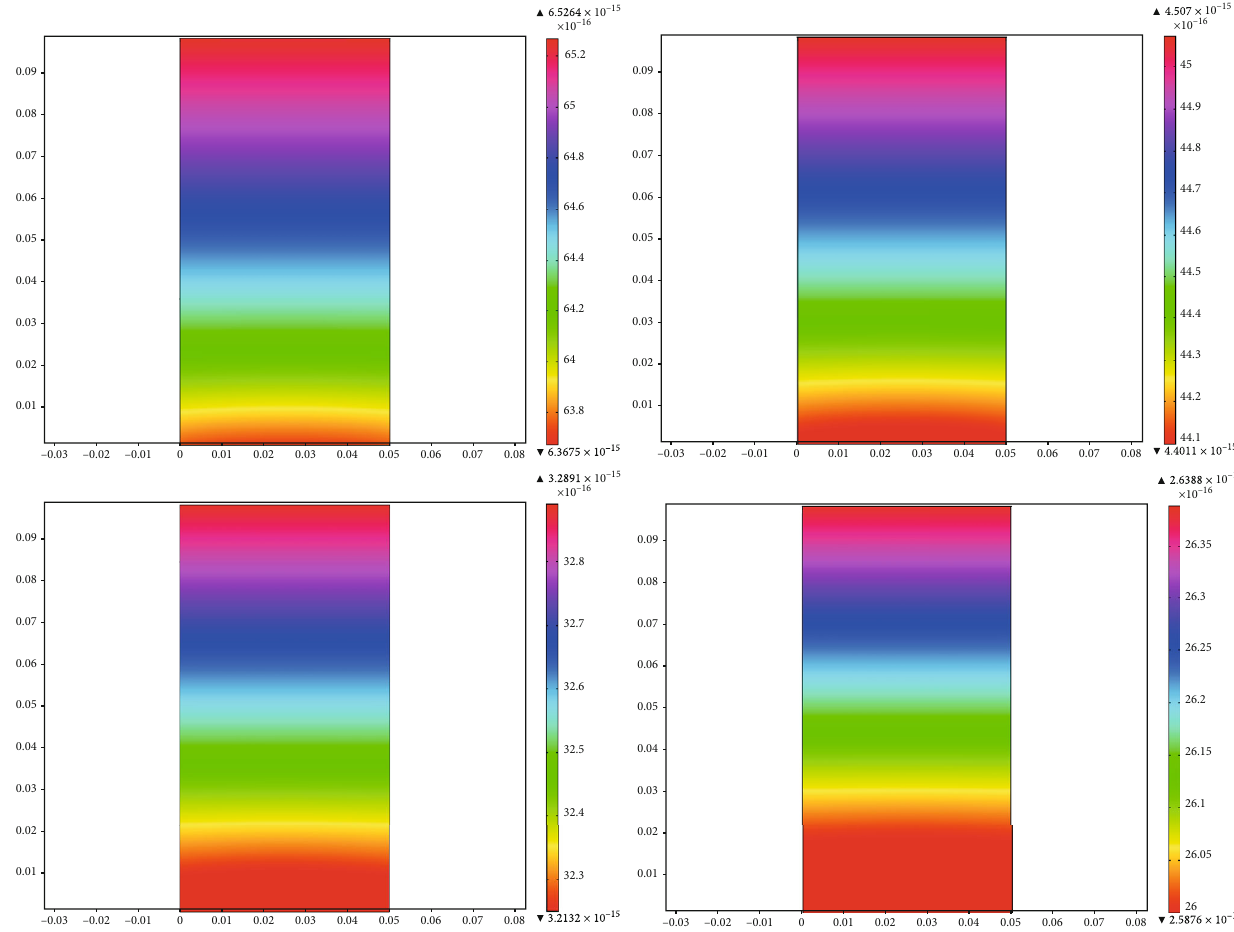
Figure 4: The change of coal body permeability under di ff erent gas pressure. (a) p = 0 : 3 MPa . (b) p = 0 : 4MPa . (c) p = 0 : 5 MPa . (d) p = 0 : 6 MPa